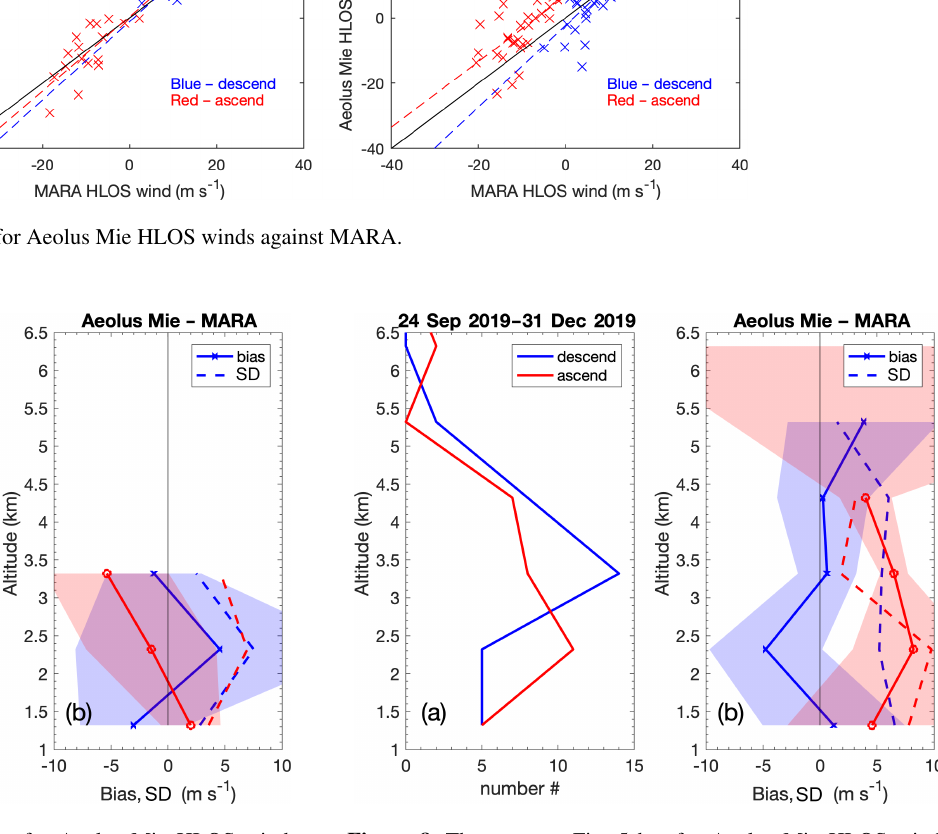
Figure 7. The same as Fig. 4 but for Aeolus Mie HLOS winds against MARA (winter).